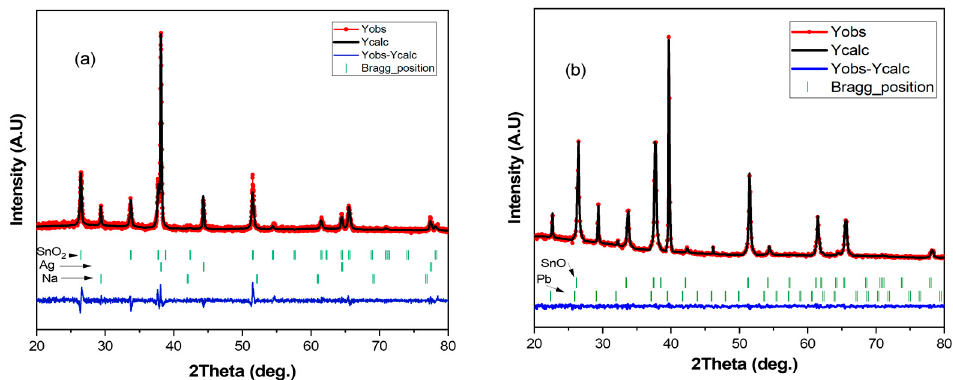
Figure 8. Plots of the Rietveld refinement given the comparison of the experiment with the calculated XRD patterns of ( a ) Ag and ( b ) Pb.